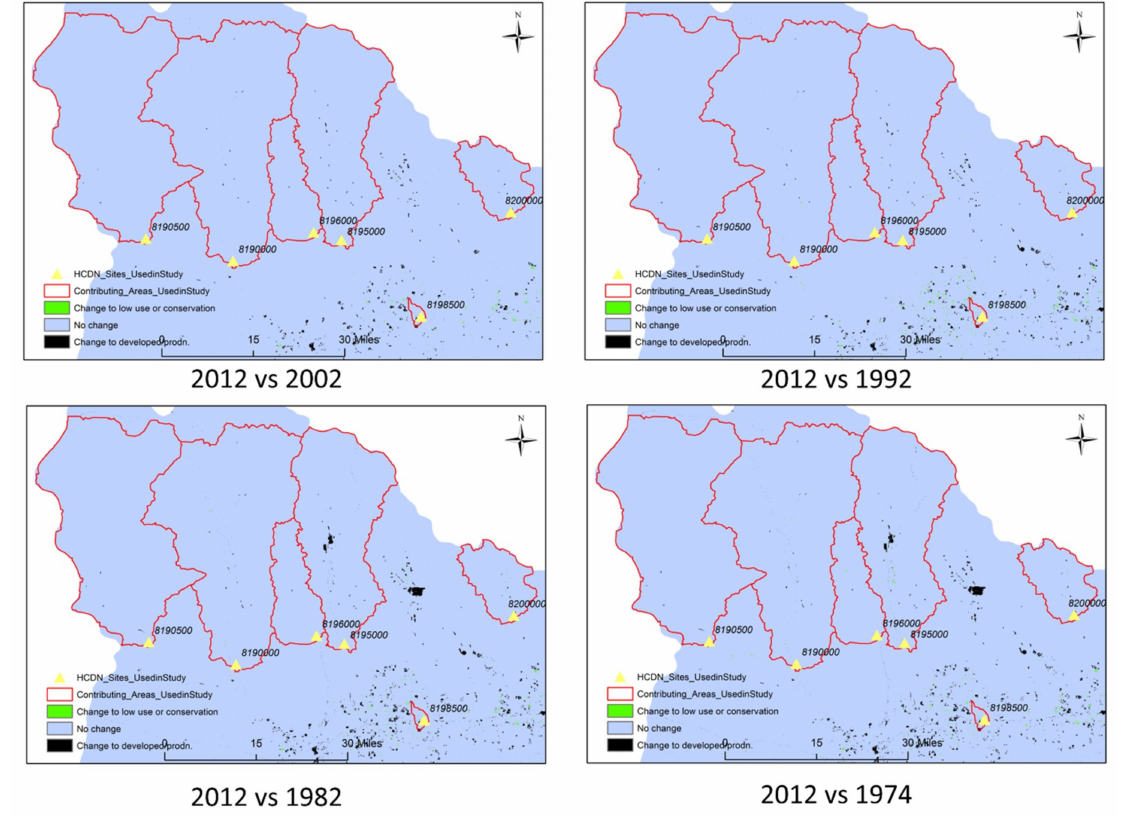
Figure 4. Land use changes from 1974 to